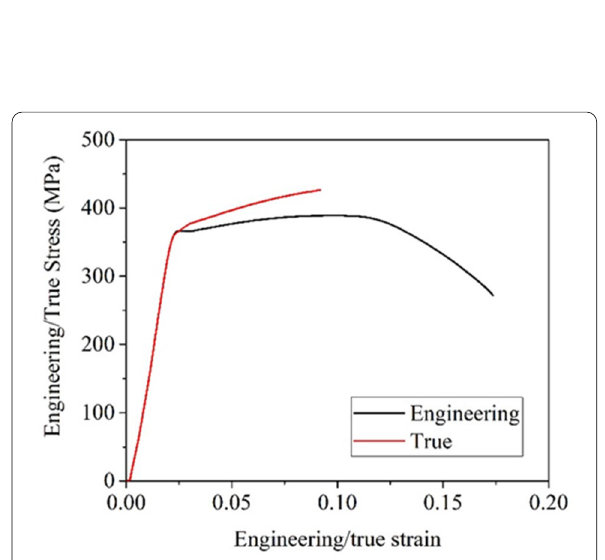
Figure 7 Engineering and true stress–strain until the ultimate tension stress curve of